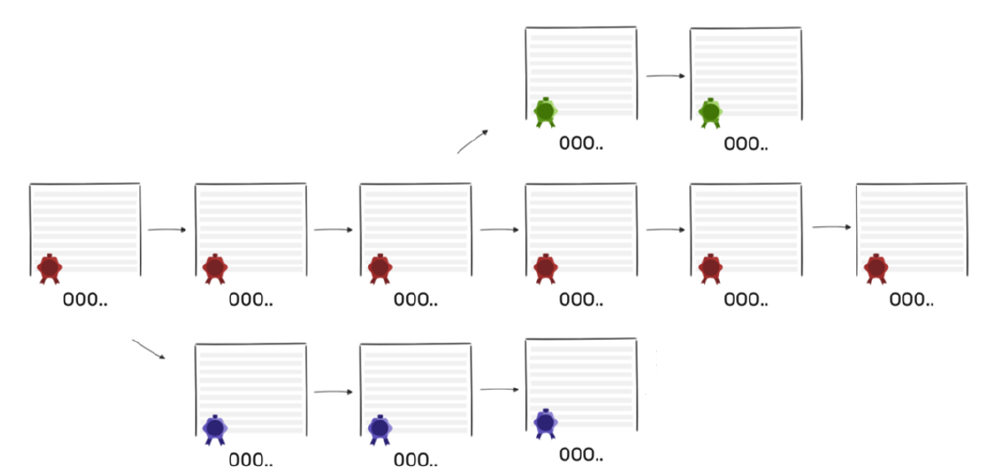
Figure 5. Longest chain in the network is the honest chain. Red is the honest chain. Green and blue are dishonest